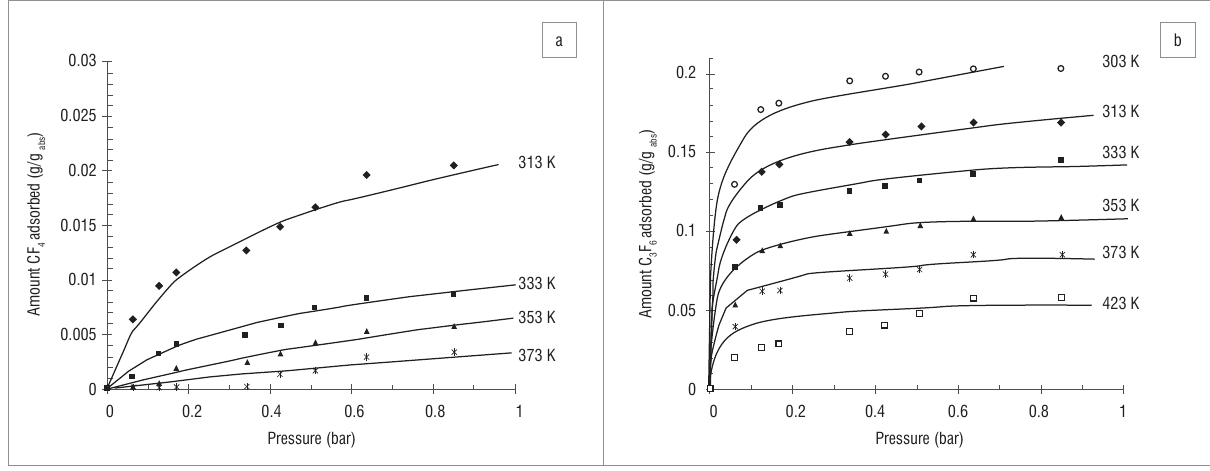
and (b) C F on MFI (silicalite-1) at different 4 3 6